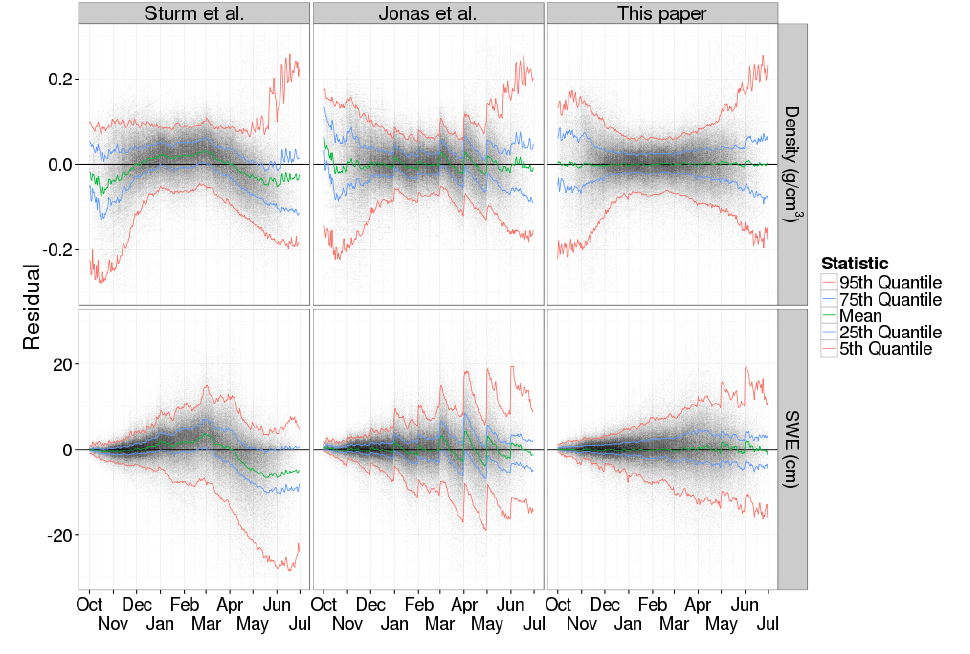
Fig. 8. All model residuals (modeled–observed) in density (upper panel) and SWE (lower panel) as a function of day of water year for each model. Green line shows mean error, blue lines indicate the inner 50th quantile of error, and the red lines the inner 90th quantile of error.